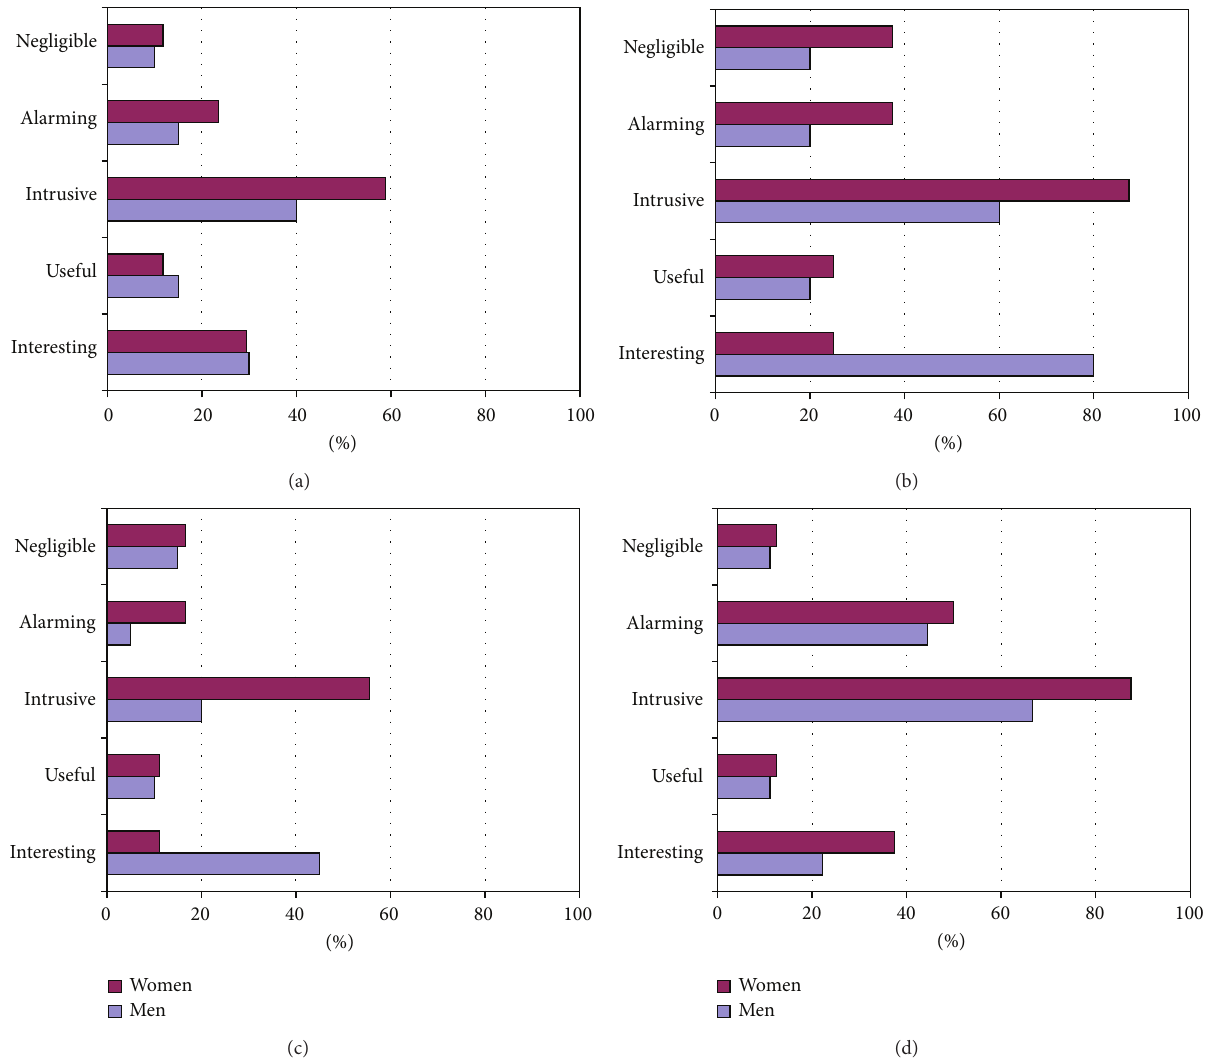
Figure 21: Definition of a service able to contact users according to the Tweet or photo location. (a) DN who claim to use location-aware applications; (b) DN who claim not to use location-aware applications; (c) DI who claim to use location-aware applications; (d) DI who claim not to use location-aware